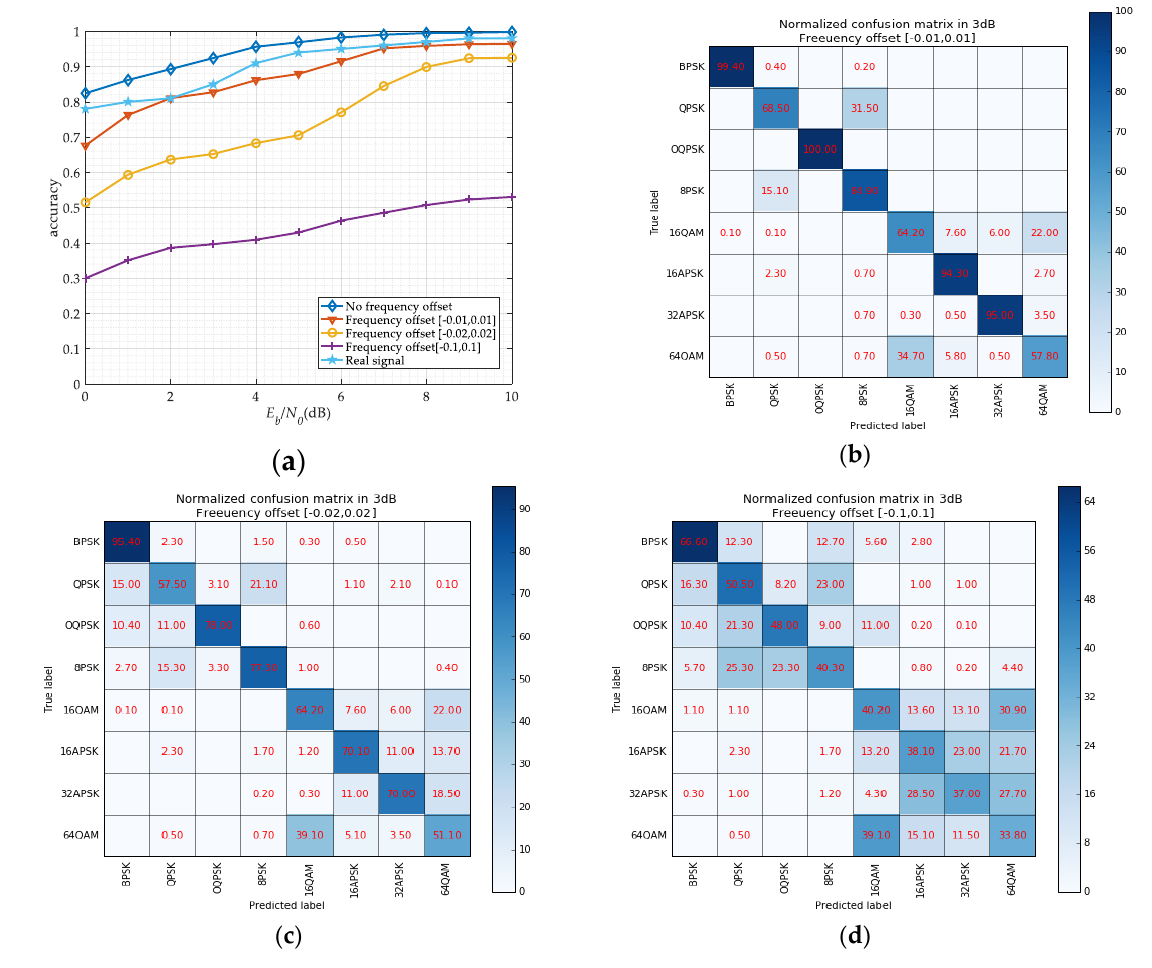
Figure 15. The network performance on different frequency offsets range. ( a ) classification accuracy for different frequency offset versus SNR; ( b ) normalized confusion matrix in 3 dB when the frequency offset is [ − 0.01, 0.01]; ( c ) normalized confusion matrix in 3dB when the frequency offset is [ − 0.02, 0.02]; ( d ) normalized confusion matrix in 10 dB when the frequency offset is [ − 0.1, 0.1].